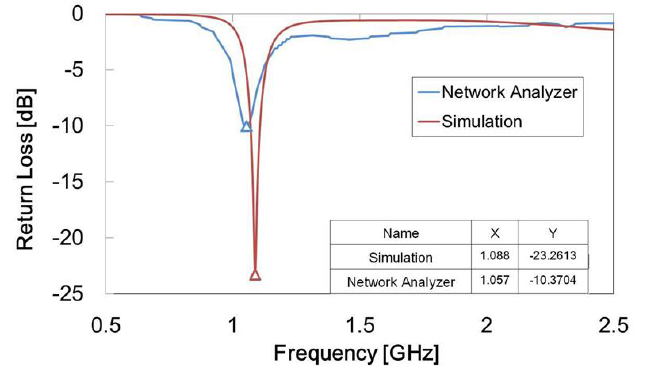
Figure 12. Line chart of experimental results compared with simulation when IPMC switch is off. The horizontal axis represents frequency and the vertical axis represents return